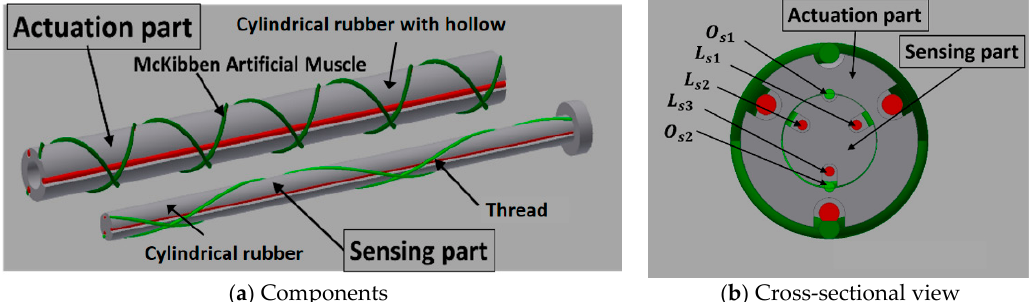
Figure 5. Configuration of the soft robot arm: ( a ) Components. ( b ) Cross-sectional view in which the sensing part is inserted into the actuation part.